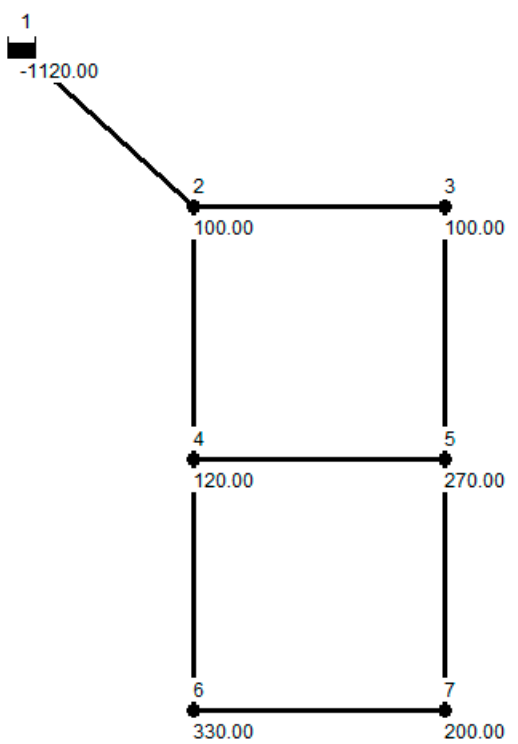
Figure 1. The layout of the two-loop example network (junction ID and water demand in m 3 / hour). Table 2. Factors applied in engineering benchmarks modified from the two-loop network design problem. Figure Values